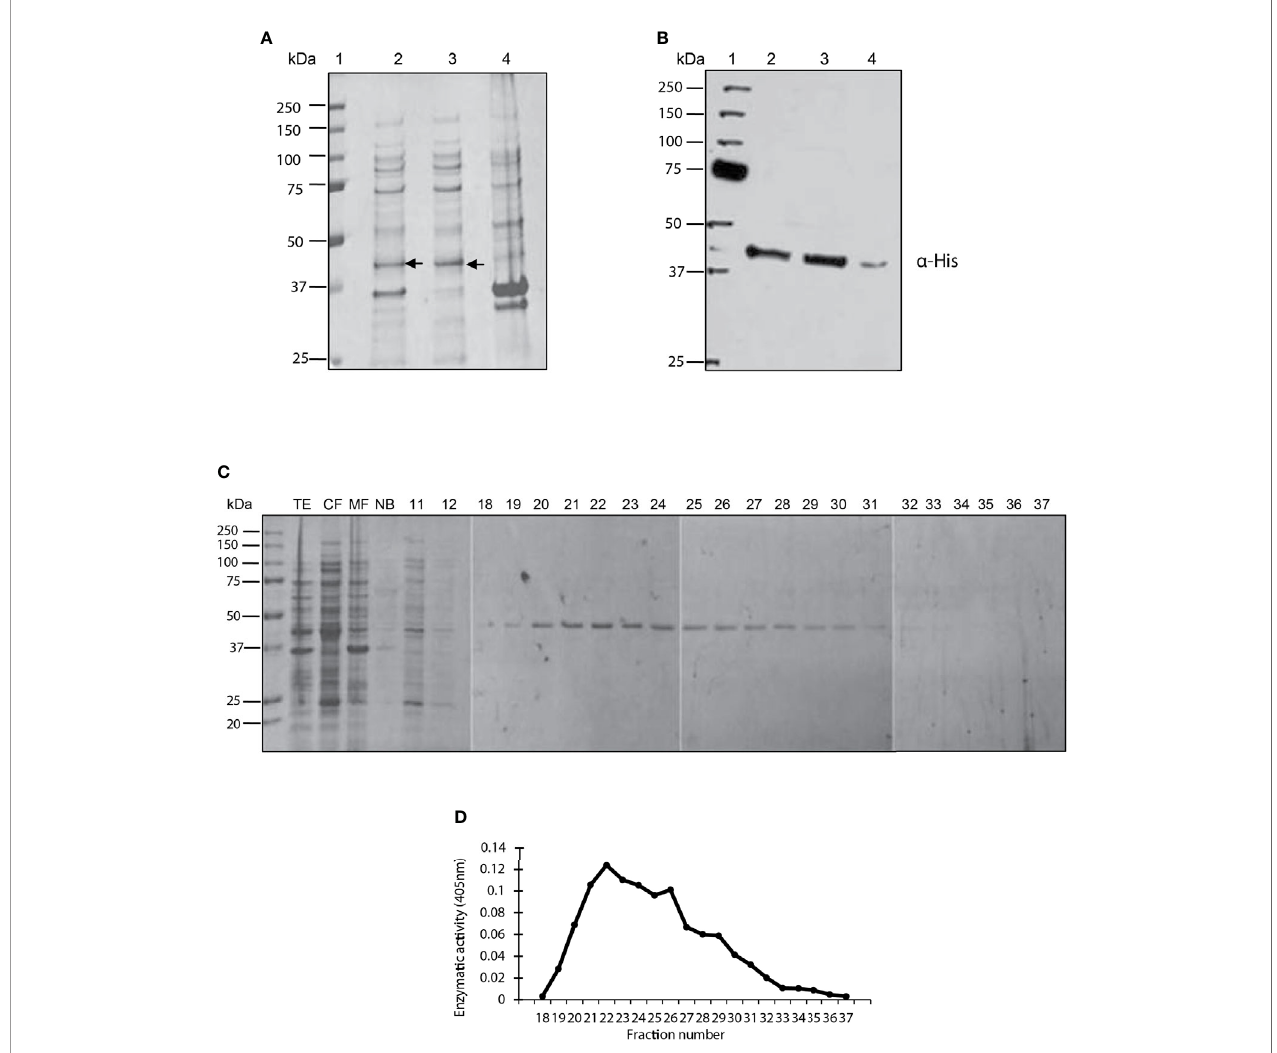
FIGURE 1 | Puri fi cation, identi fi cation and analysis of enzymatic activity of the PP2C of Leishmania mexicana . (A) Expression of PP2C of L. mexicana in different subcellular fractions of Escherichia coli cells. Molecular weight marker (line 1); total extract prepared from the E. c oli codon plus, induced with IPTG (line 2); cytosolic fraction (line 3); and membrane fraction (line 4). The three extracts were evaluated on SDS-PAGE gel stained with Coomassie blue. (B) Western blot analysis of the same sample used in molecular weight marker (line 1); total extract prepared from the E. coli codon, induced with IPTG (line 2); cytosolic fraction (line 3); and membrane fraction (line 4). The C-terminal His-Tag was detected with a monoclonal antibody. (C) Puri fi cation steps, utilizing SDS-PAGE gel stained with Coomassie blue dye. The cytosolic fraction (CF) was applied to a Ni 2+ – NTA resin and the bound material eluted with an imidazole gradient. TE, CF, MF and not bound (NB); 11 and 12 correspond to the washes; 18-37 are the eluents from which the puri fi ed protein was obtained. (D) The phosphatase activity of the eluents 18-27 was examined by using p-NPP as the protein with an approximate molecular weight of 45.2 kDa ( Figure 1C ). Phosphatase activity was evidenced in fractions 22-25 by a broad peak ( Figure 1D ). Identi fi cation of PP2C in Different Leishmania Species The PP2C protein was detected with antibodies against recombinant Lmx PP2C (anti- Lmx PP2C) applied to TE promastigotes of various Leishmania species ( Figure 2 ): L . (V.) panamensis MHOM/PA/71/ LS94 (lane 1) , L. (V.) brazilienzis MHOM/BR/75/M2903 (lane 2), L. ( L. ) venezuelensis MHOM/VE/80/PMH3 (lane 3), L. (V.) donovani